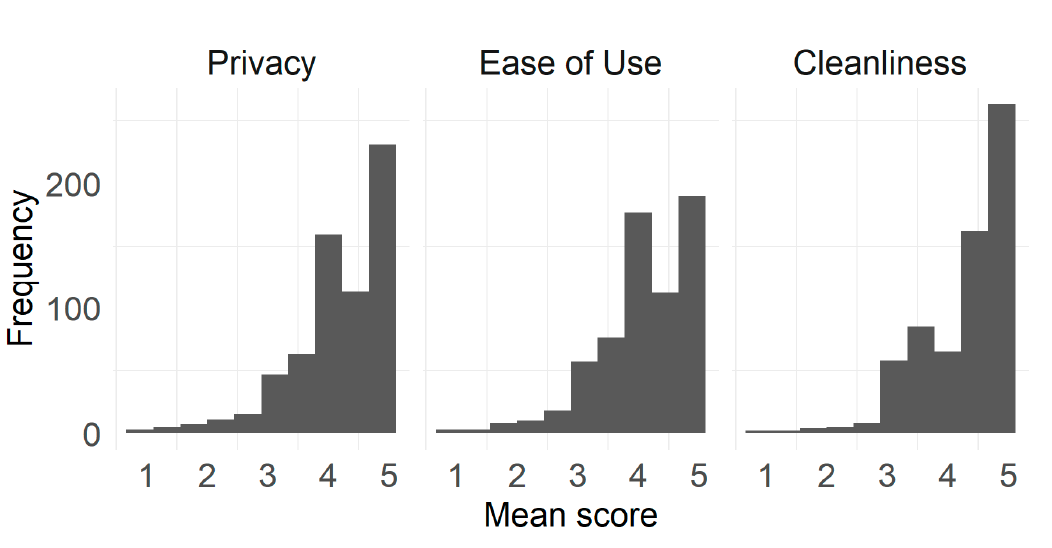
Figure 2. Distribution of mean scores of each factor.